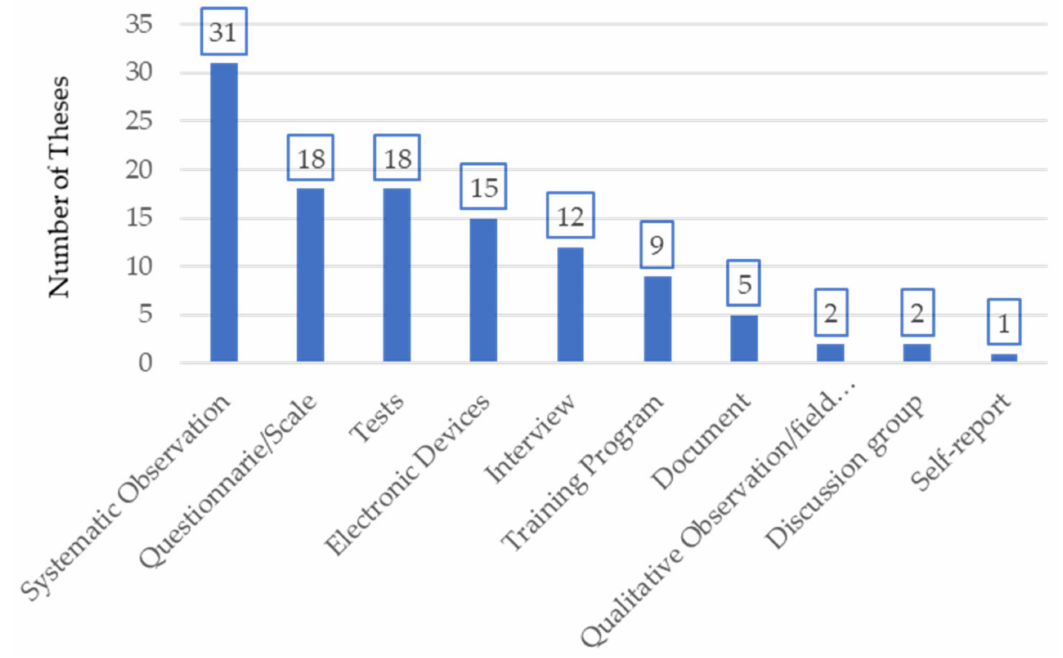
Figure 6. Distribution of the instruments used in doctoral theses on